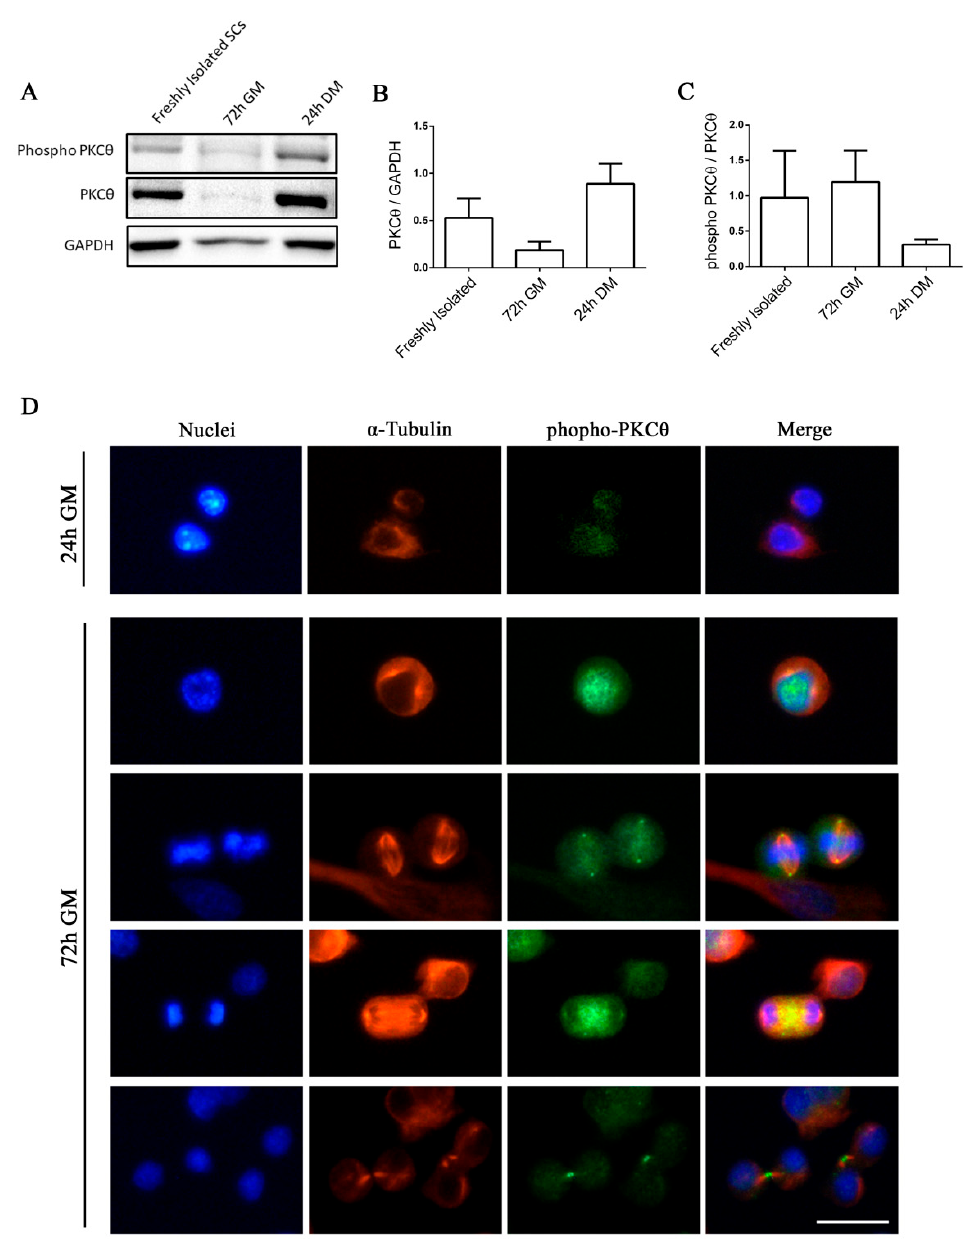
Figure 1. Phospho-PKC θ is localized to the nucleus, centrosomes, mitotic spindle and midbody in satellite cells during mitosis. ( A ): WB analysis showing PKC θ and phospho-PKC θ expression in activated SCs (freshly isolated), proliferating SCs (72h GM), di ff erentiated myotubes (24h DM) ( n = 3 individual experiments). ( B ): WB densitometric analysis of the level of PKC θ expression, normalized on the level of GAPDH protein. ( C ): WB Densitometric analysis of the phospho-PKC θ / PKC θ ratio. ( D ): Representative immunofluorescence images of satellite cells after 24h and 72h in culture, stained for α -Tubulin (red) and phospho-PKC θ (green). Nuclei were counterstained with Hoechst. Scale bar 20 µ m. Error bars represent mean ± sem.